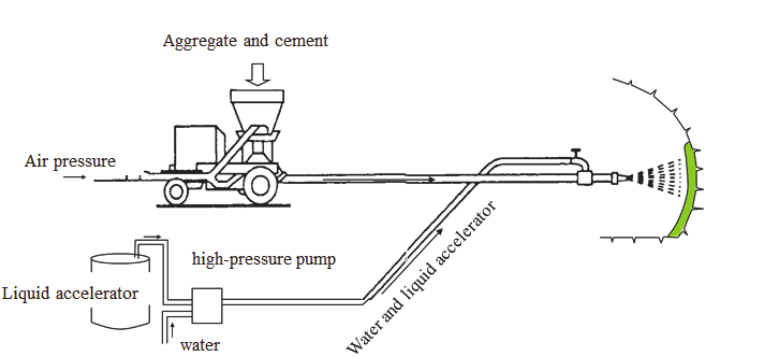
Figure 14: The liquid accelerator matching spraying technology. Figure 15: New field shotcrete